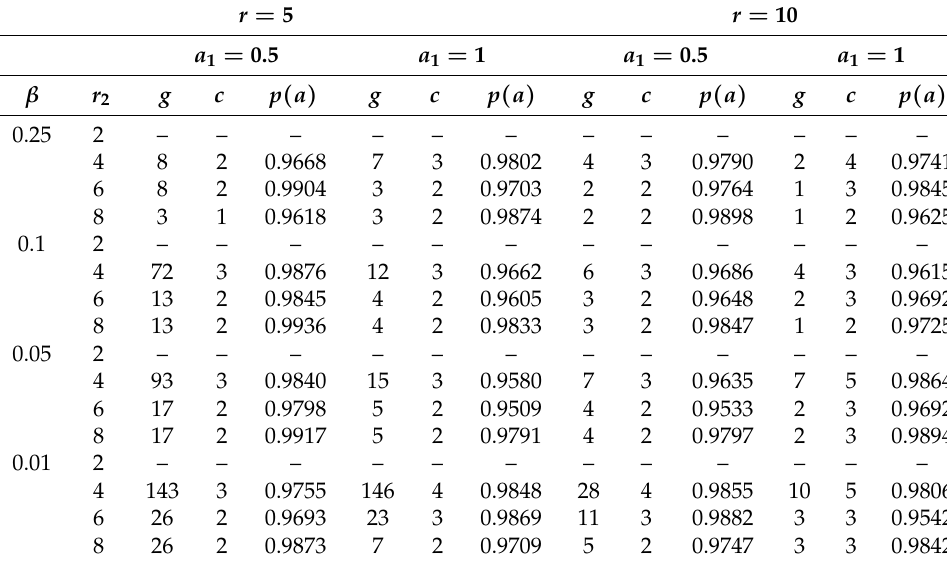
Table 6. GASP under CBellW model, ˆ β = 0.2916 and ˆ λ =